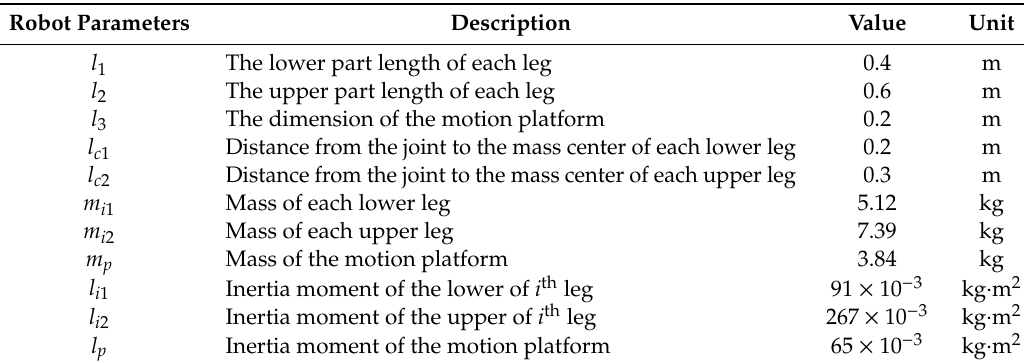
Table 2. The parameters of the control